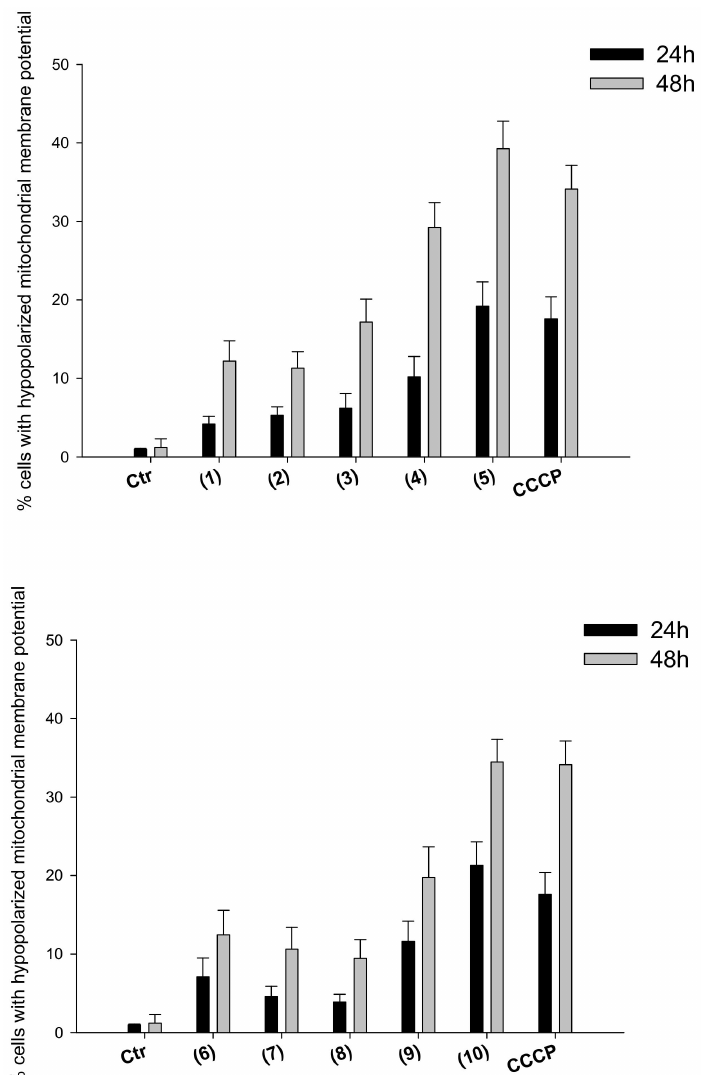
Figure 6. Mitochondrial membrane potential. E ff ects of silver(I) complexes on mitochondrial membrane potential. 2008 cells were treated for 24 h or 48 h with IC 50 concentrations of tested complexes or CCCP (3 µ M). The percentage of cells with hypopolarized mitochondrial membrane potential was determined by Mito-ID ® Membrane Potential Kit. Data are the means of three independent experiments. Error bars indicate